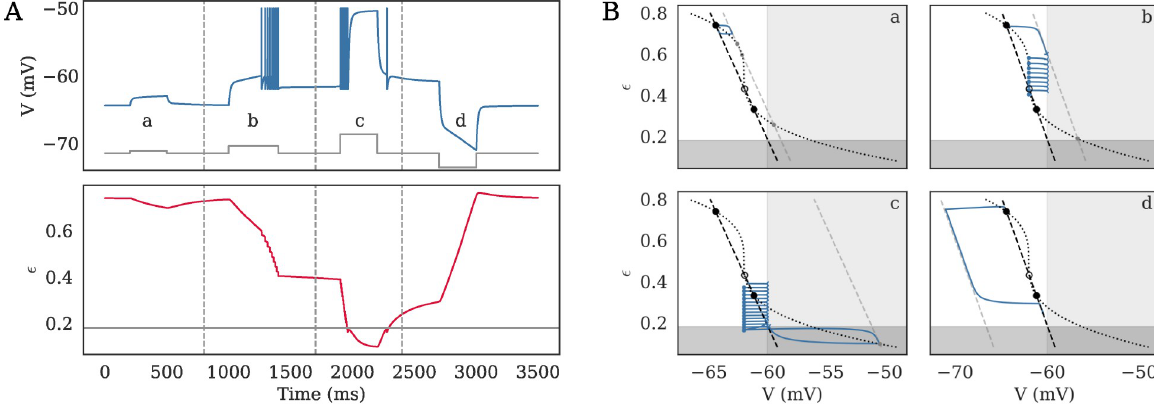
Fig 3. Dynamics of the e LIF model as timeseries (A) and in phase-space (B) in the bistable regime. A . The behavior of the model is shown in response to four different inputs, shown in grey on the V subplot: a low depolarizing current (a: 10 pA), a stronger depolarizing current (b: 30 pA), a large depolarization (c: 80 pA), and a hyperpolarizing current (d: -60 pA). For visualization purposes, action potentials are made visible by setting the voltage to -50 mV at spike time. B . Corresponding behavior in phase-space is shown, each subplot corresponding to one of the four domains separated by the grey dashed lines on panel A. The black curves mark the resting nullclines and the light grey line marks the input-driven V - nullcline; resting fixed points (FPs) are marked by the large black circles while input-driven FPs are show by the small grey circles and spike emissions are marked by empty left triangles while reset positions are marked by blue dots. The neuron displays the following behaviors: (a) subthreshold dynamics, where the neuron temporarily leaves the high-energy FP, associated to the down-state, then goes back towards it, (b) transition from the initial high-energy FP to the low-energy FP (up-state) through a spiking period, (c) transition from the up-state to a depolarization block via a spiking period before returning towards the up-state, (d) transition from up- to down-state. See S2 Table for detailed